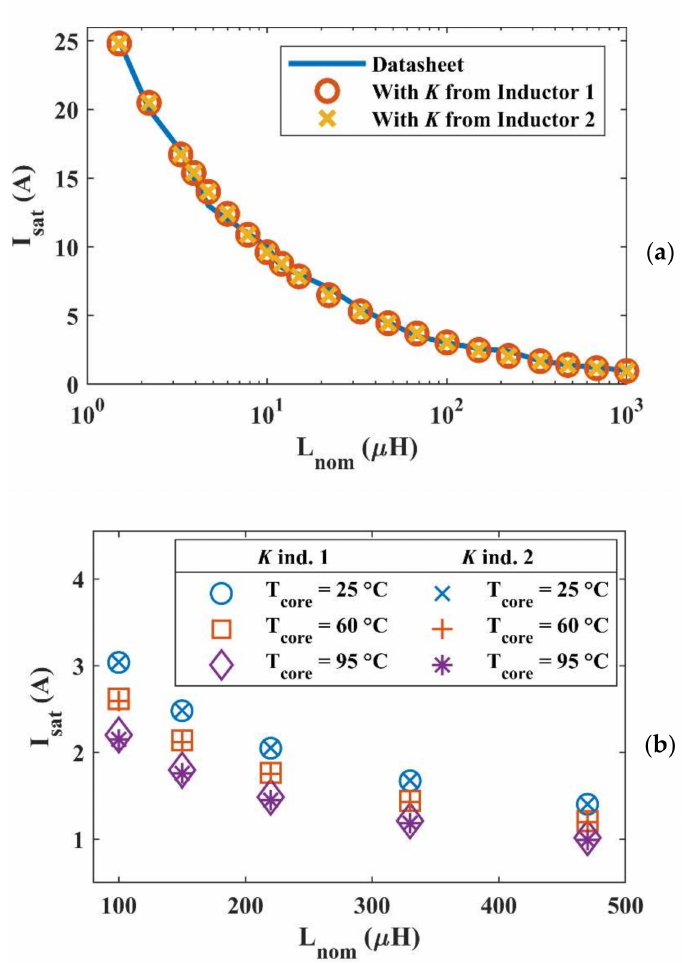
Figure 6. Simulations of the saturation current vs. inductance characteristic of the inductor family. The K factor of (13) was extrapolated from the experimental data of inductors 1 and 2: ( a ) Comparison of the simulation calculated with K extrapolated from inductor 1 and inductor 2 with the information given by the datasheet at T core = 25 ◦ C. The abscissa is on a logarithmic scale for better visualization. ( b ) Comparison of the simulated saturation currents obtained at different temperatures with K extrapolated from inductor 1 and from inductor